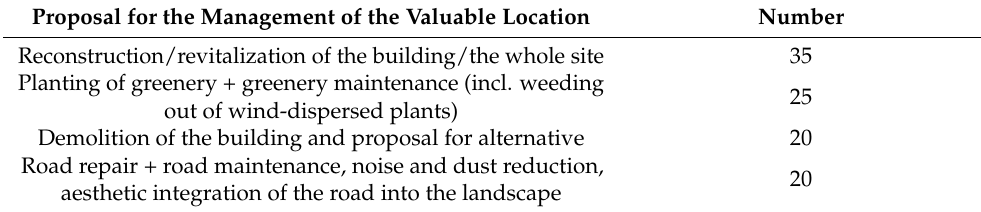
Table 5. Proposed solutions for problematic locations (in both built-up areas and open landscape)— all